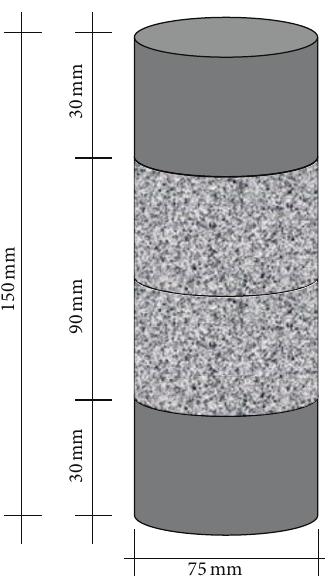
Figure 2: Schematic image of a concrete test cylinder: 30 MPa com- pression resistance, 𝑤/𝑐 = 0.50 , one-day